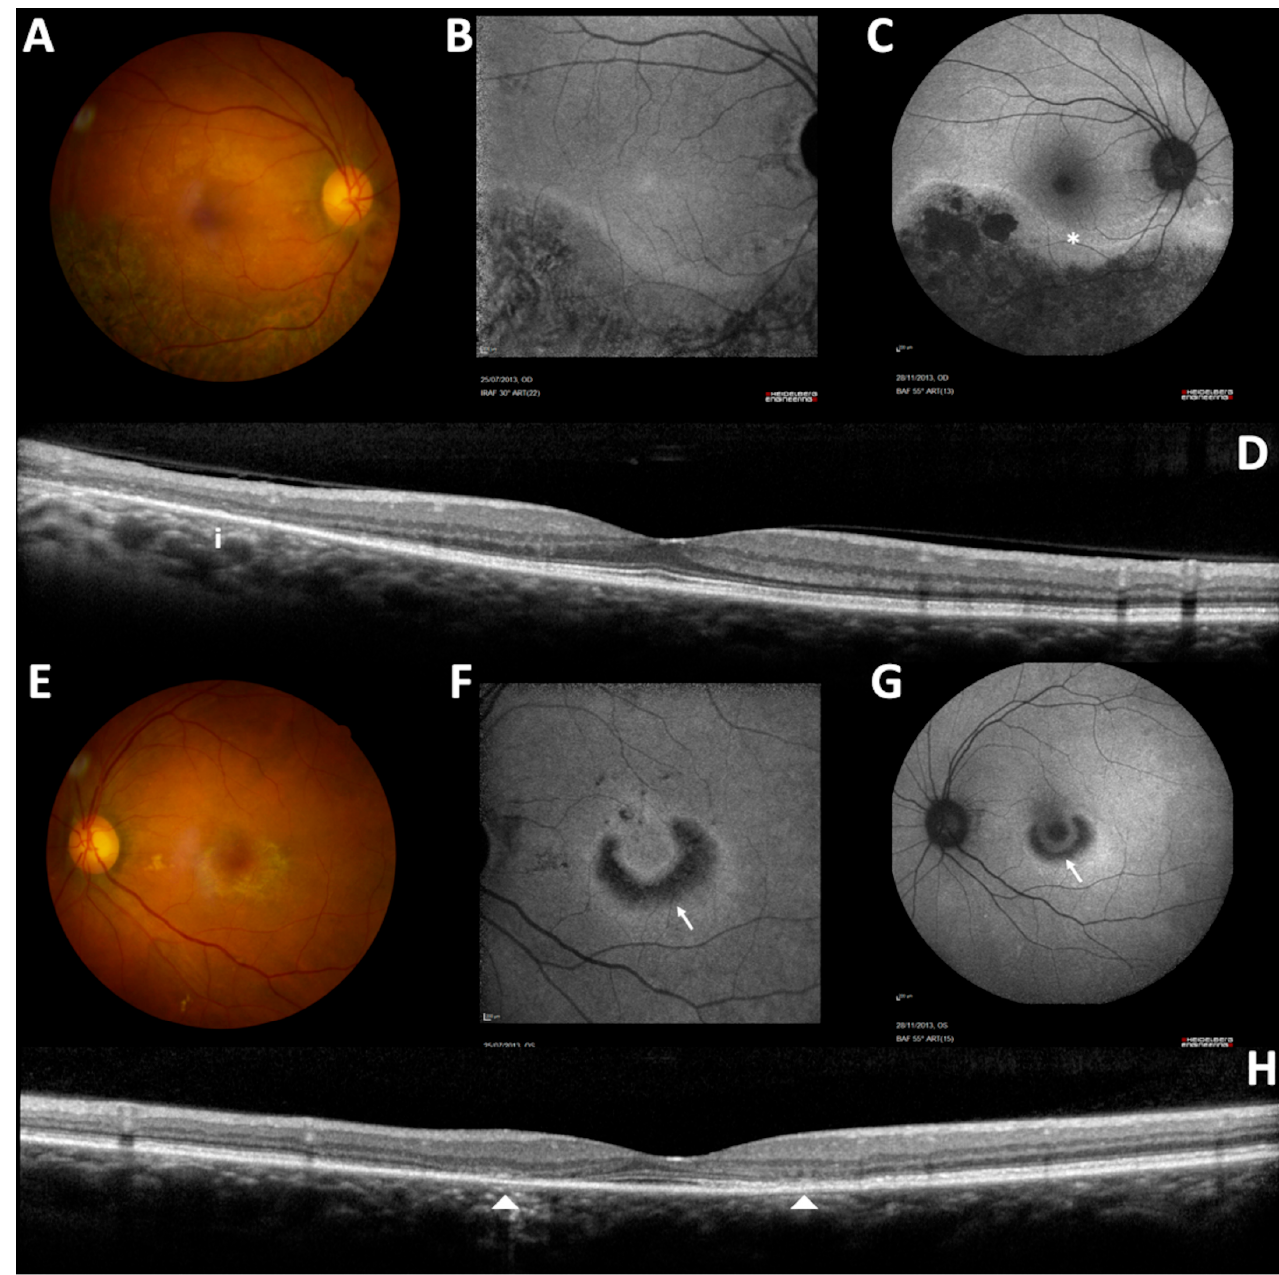
Figure 3. Left and right eye imaging at presentation: color fundus ( A , E ); 32° ( B , F ); and 55° ( C , G ) fundus autofluorescence imaging and spectral-domain optical coherence tomography (OCT) (macular vertical scan) ( D , H ). The RE showed pericentral hydroxychloroquine (HCQ) toxicity pattern with an atrophic hypoautofluorescent area along the inferior temporal vascular arcade delimited by a hyperautofluorescent line (*). The LE showed a perifoveal HCQ toxicity pattern with a typical “bull’s eye maculopathy” (arrow). Vertical SD-OCT scans demonstrated loss of the external limiting membrane, ellipsoid zone and interdigitation zone along the inferior temporal vascular arcade in the RE (i) and in the parafoveal area in the LE (arrow heads).